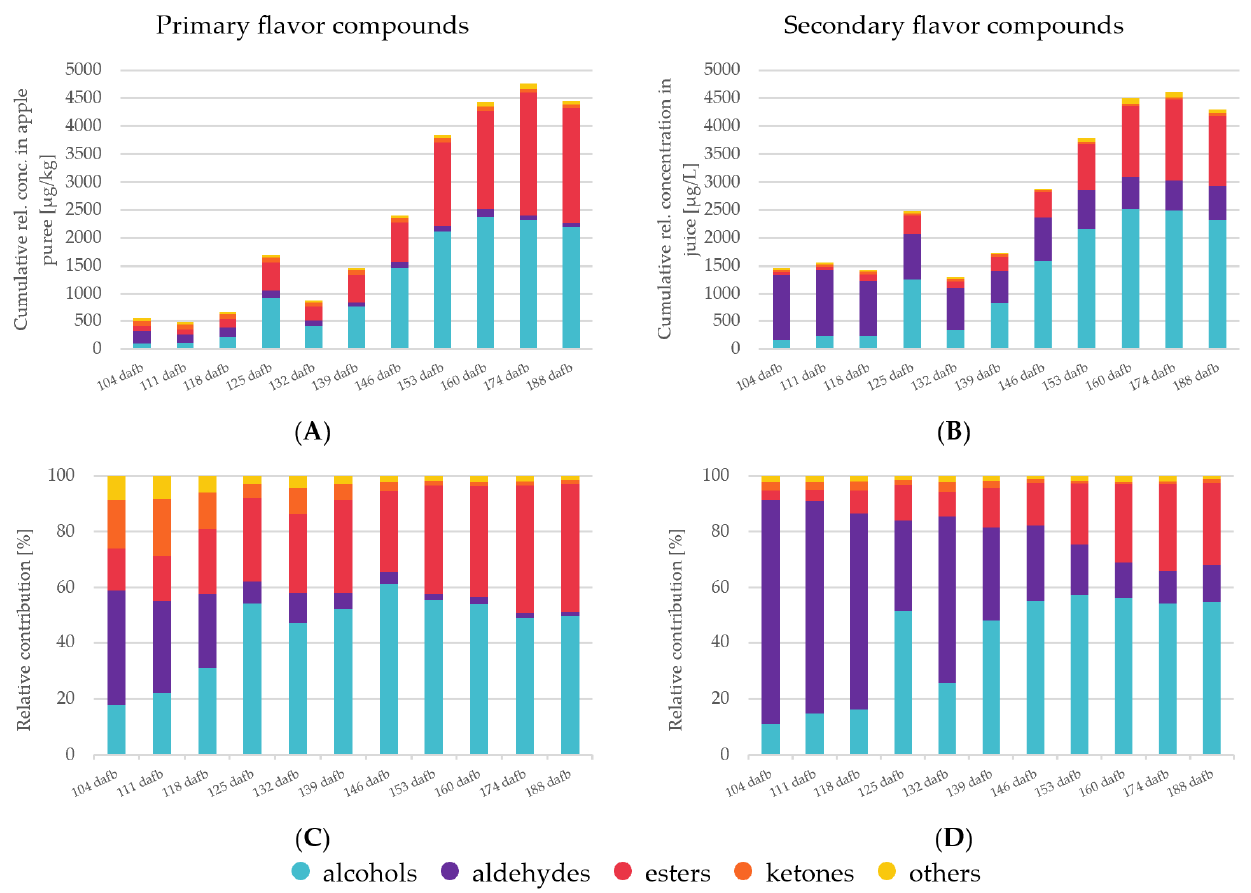
Figure 1. The cumulative concentration and relative contributions of different compound classes is depicted in four diagrams. ( A )—relative cumulative concentration of primary volatiles; ( B )—relative cumulative concentration of secondary volatiles; ( C )—relative contribution of the compound classes to the rel. cumulative concentration in primary volatiles; ( D )—relative contribution of the compound classes to the rel. cumulative concentration in secondary volatiles.